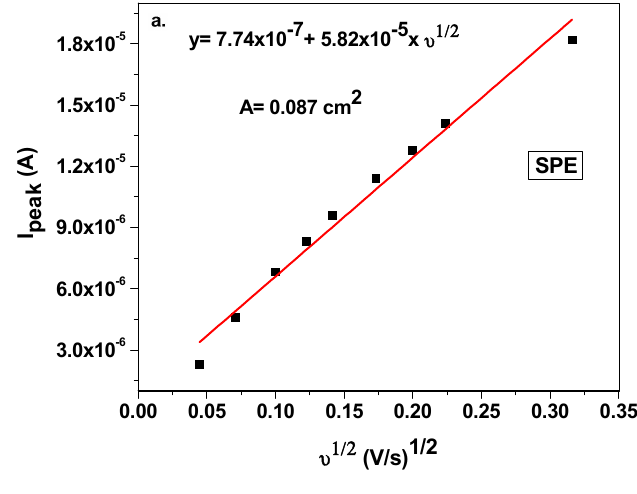
Figure 5. CVs recorded with SPE ( a ) and SPE-Gr ( b ) in the presence of 10 -3 M K 4 [Fe(CN) 6 ] in 0.2 M KCl supporting electrolyte at various scanning rates, from 2 to 100 mV/s; comparison between two CVs recorded with SPE and SPE-Gr; 50 mV/s scan rate ( c